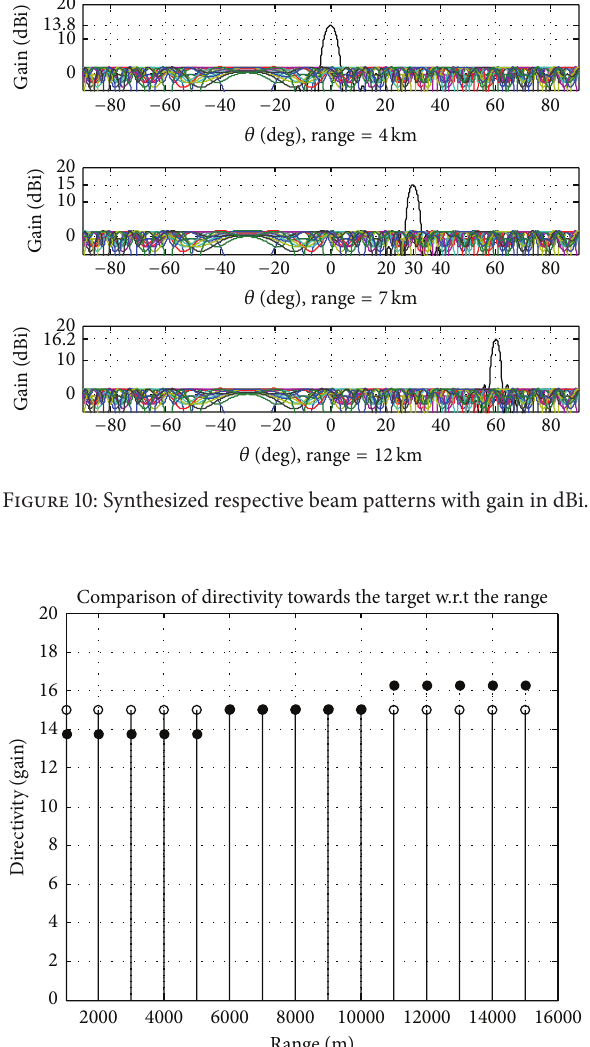
Figure 11: Comparison of incident power on the target with respect to the